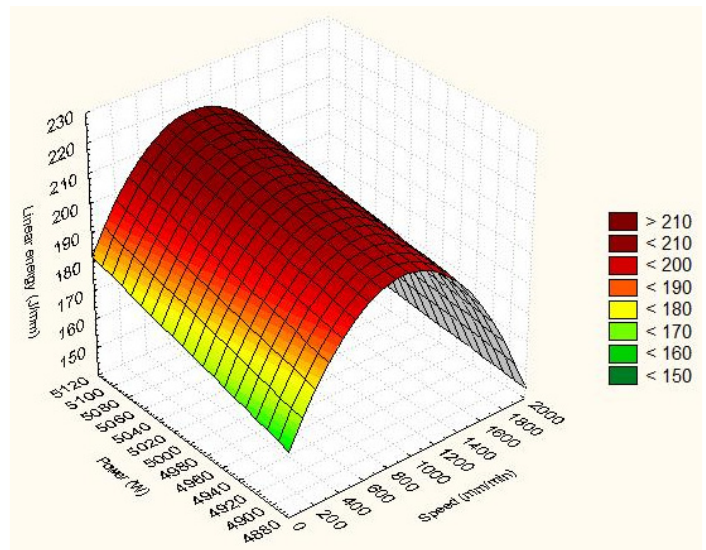
Figure 8. Quadratic dependence of linear energy on power and speed.